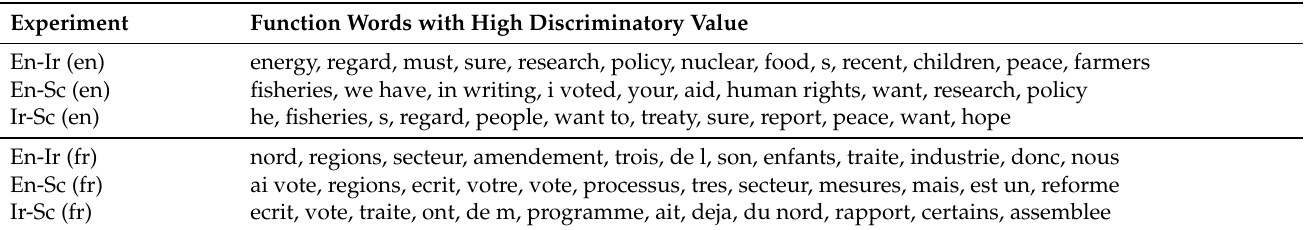
Table 3. The top most relevant word n-grams in binary text classification